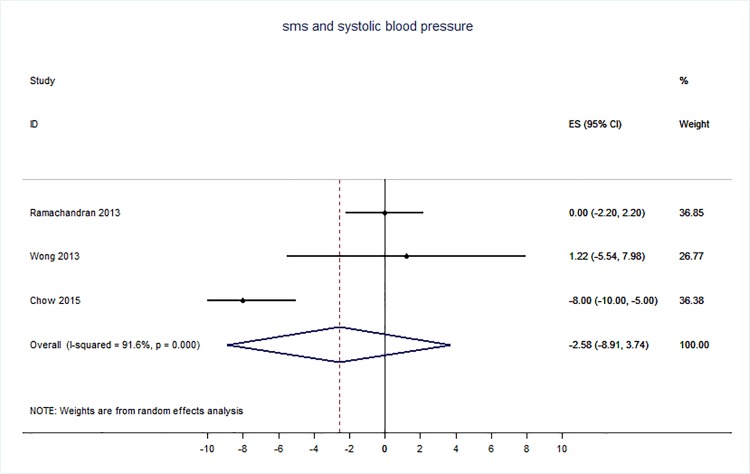
Physical activity and diet interventions using SMS function–systolic blood pressure (mmHg).